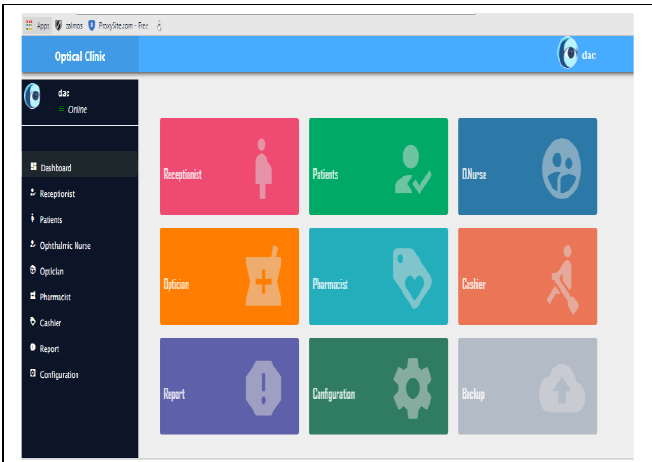
Figure 17. Admin Home Interface